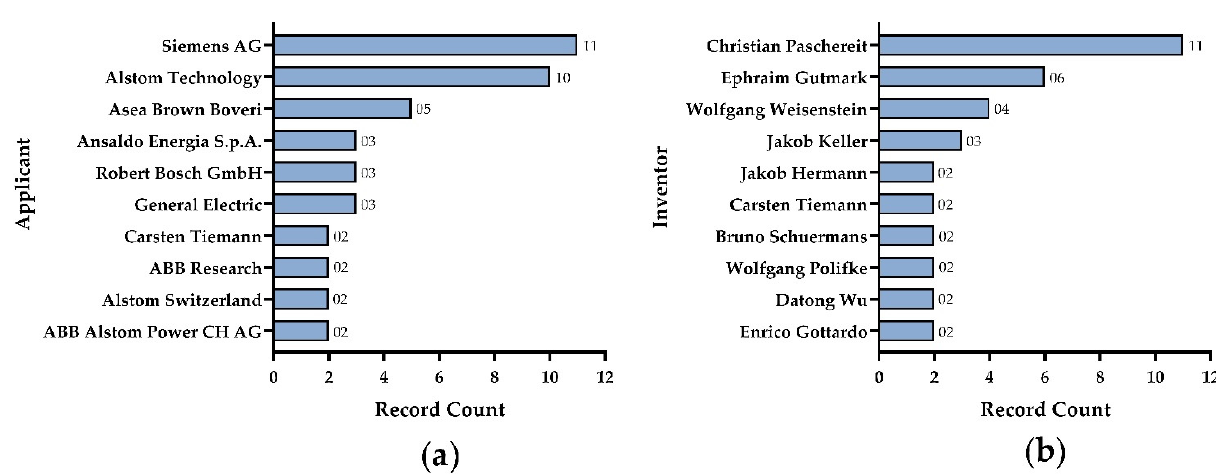
Figure 2. Analysis of the main ( a ) applicants and ( b ) inventors of the prospected technologies.